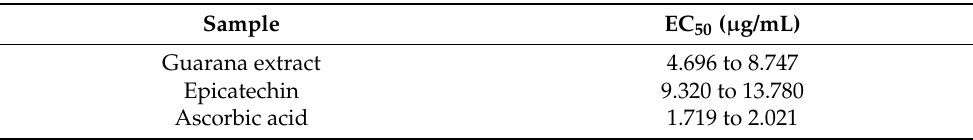
Table 2. In vitro antioxidant activity of guarana and epicatechin compared to a positive control, ascorbic